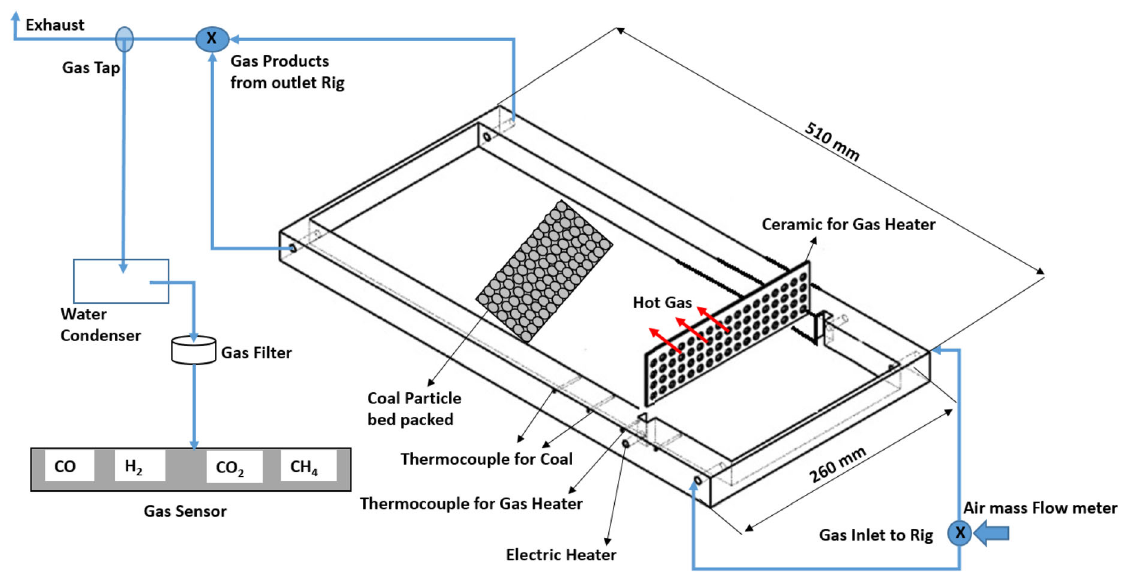
Fig. 2 Schematic diagram for